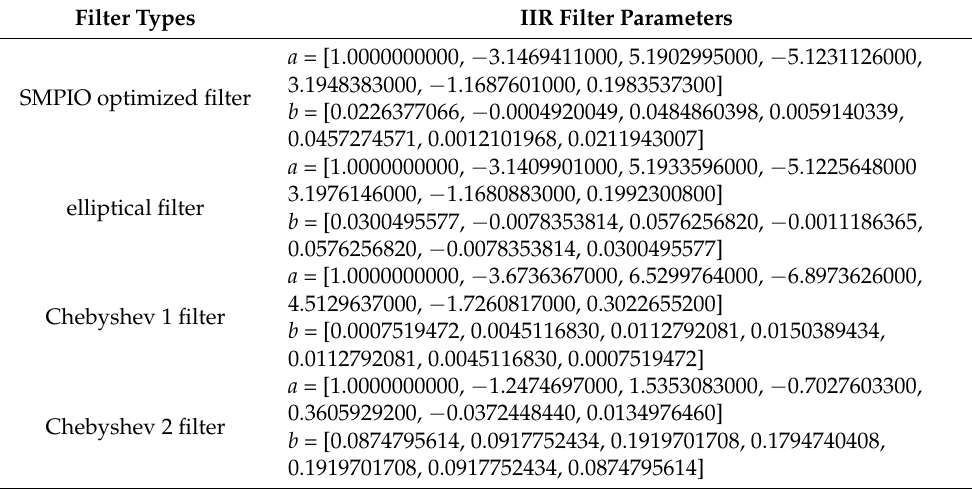
Table 3. Various types of IIR filter parameters ( ω s = 300 Hz, ω p = 400 Hz, m = 6, amplitude optimized). Filter Types